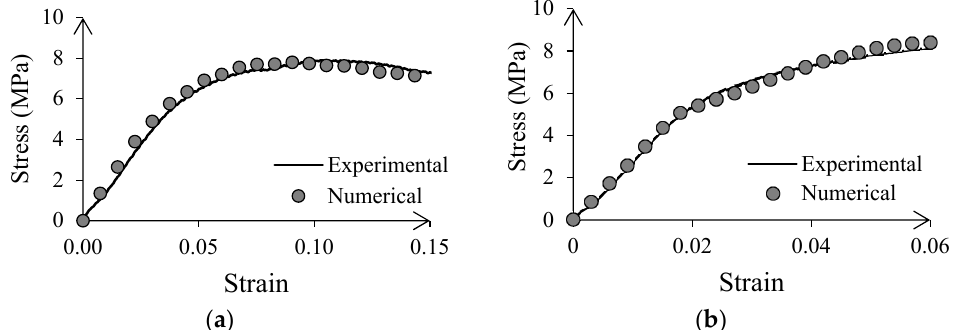
Figure 2. Experimental and numerical results of uniaxial compression testing of: ( a ) Cellular capsules and, ( b ) stone mastic